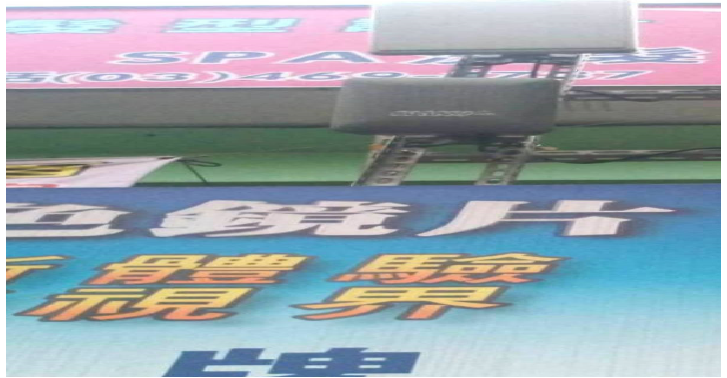
Figure 13. Two TMRDs deployed at the road site.